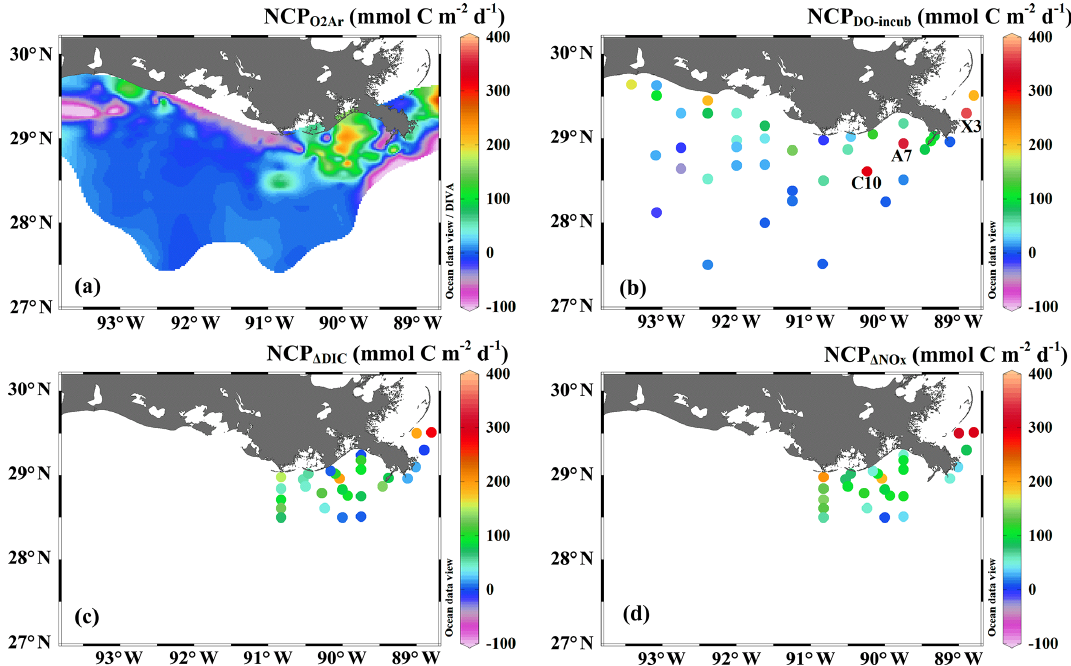
Figure 5. The spatial variability of (a) NCP O were only estimated in the Mississippi plume (c, d) . Figure generated by Ocean Data View (Schlitzer,